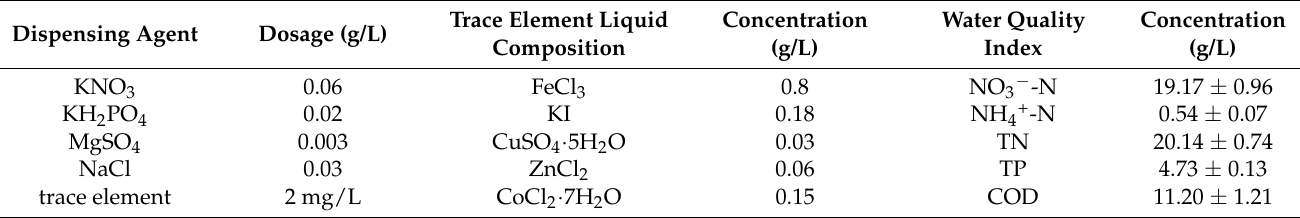
Table 1. Quality and formula of distributed